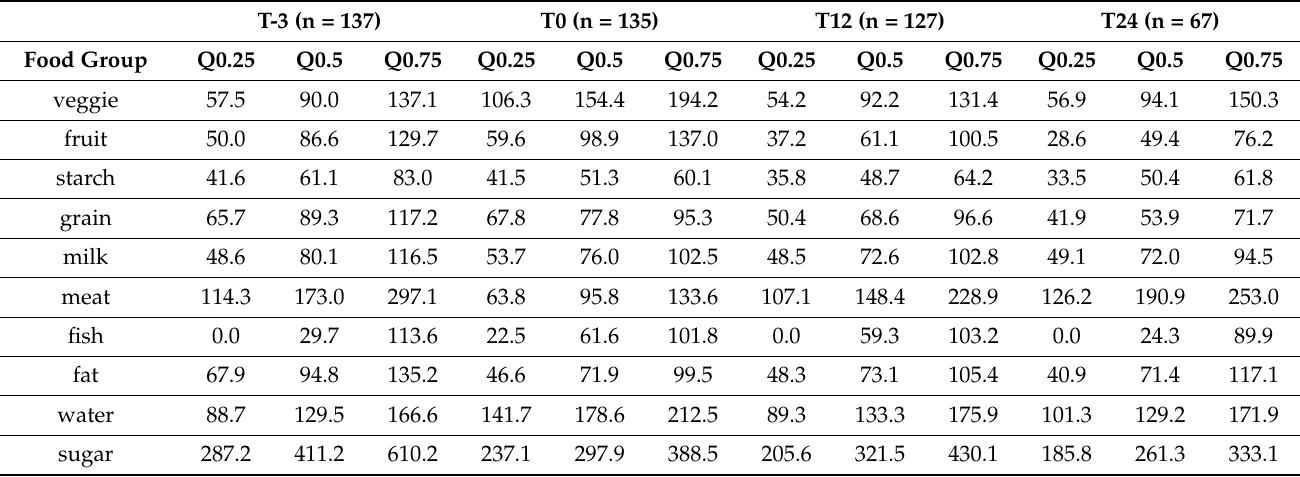
Table 1. Food consumption of the study population at enrollment (T-3), directly after intensive inpatient rehabilitation (T0) and at 12-month (T12) as well as 24 months follow up